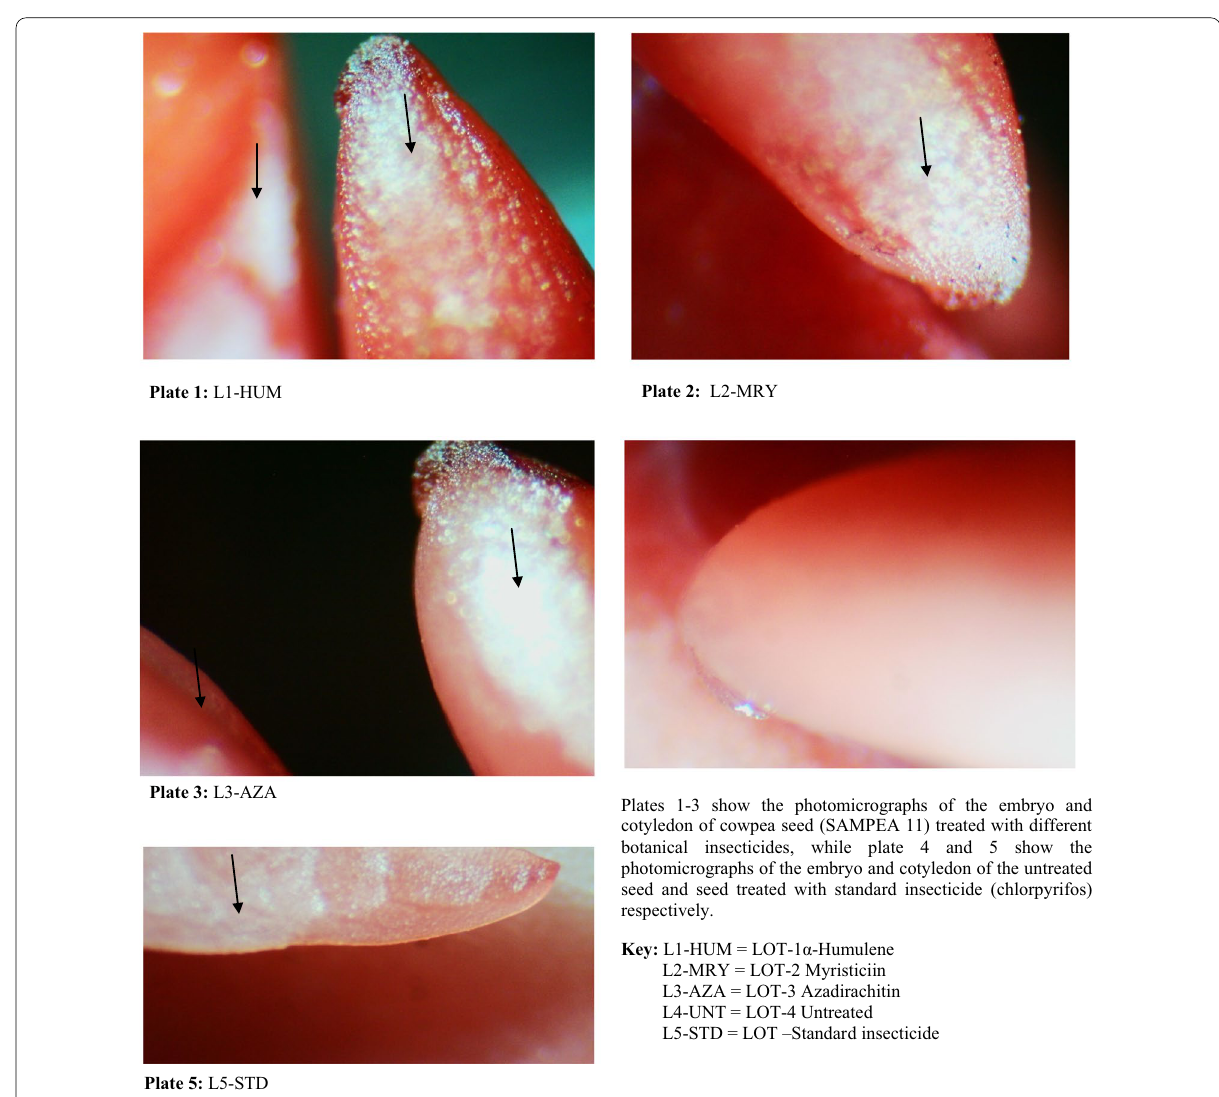
Fig. 4 Photomicrograph of the Embryo and Cotyledon of Seed of Cowpea Cultivars treated with Botanical